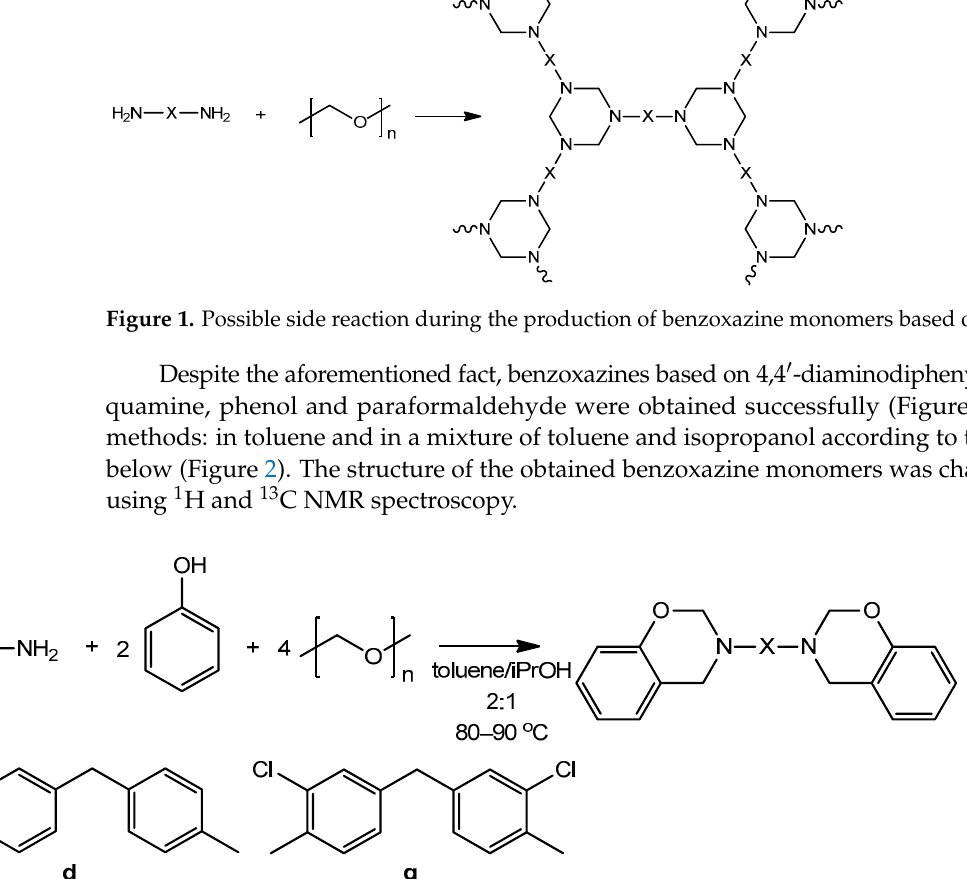
Figure 3. 1 H NMR spectrum of benzoxazine based on quamine in various solvents. Table 2. 1 Н and 13 C NMR spectroscopy data for benzoxazine monomers. Sample Proton Chemical Shifts Δ h (ppm)